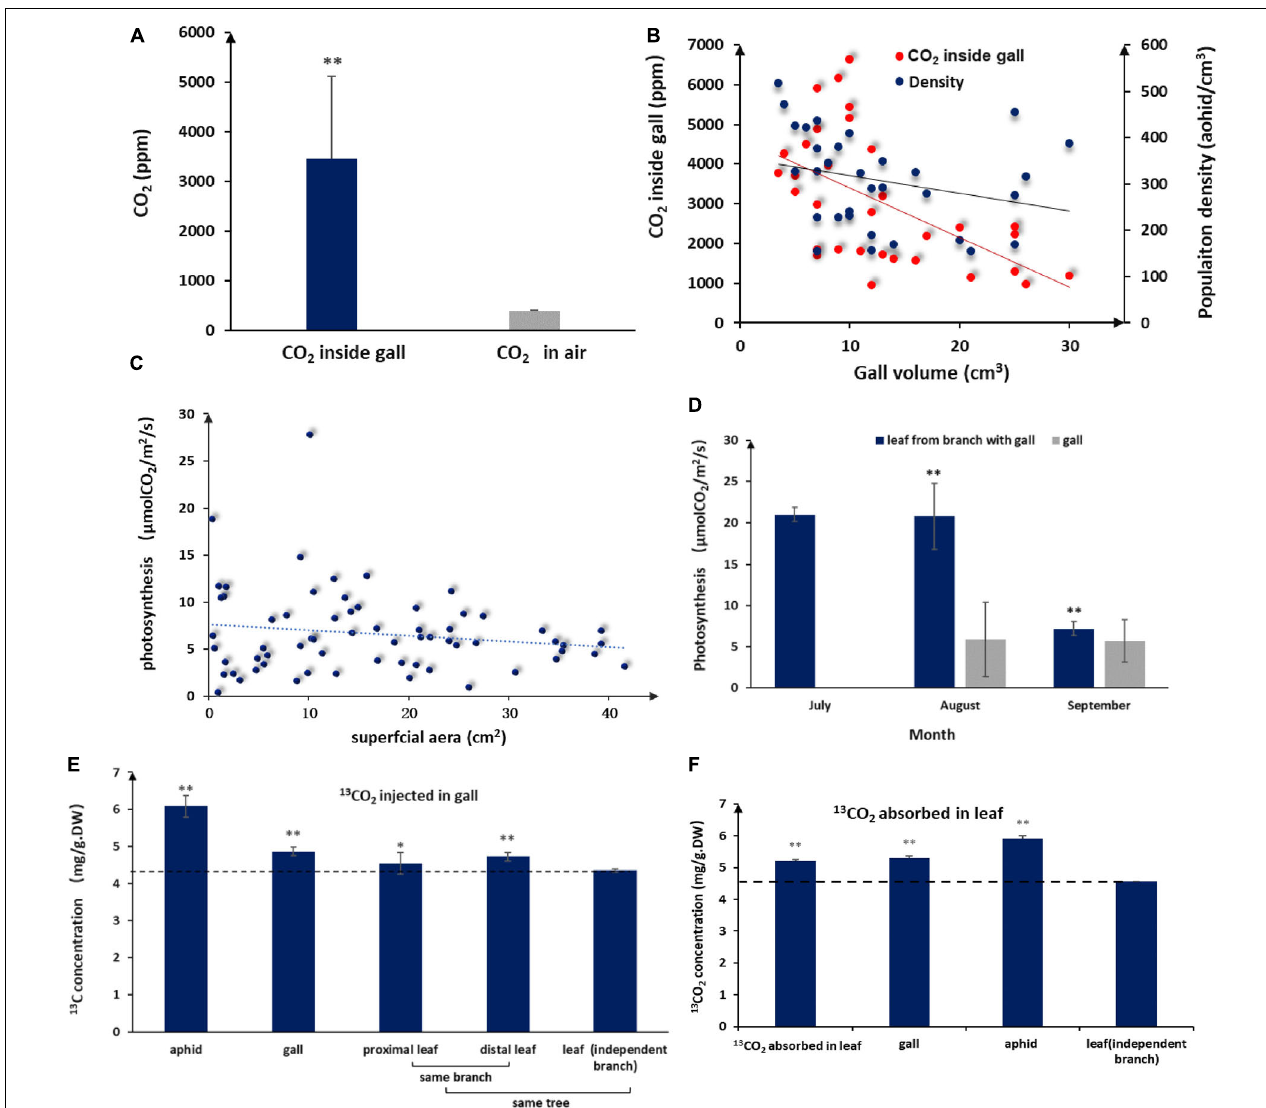
FIGURE 2 | Elevated CO 2 and photosynthesis levels in galls and leaves. (A) Average interior and exterior CO 2 concentrations ( n = 32, error bars denote SD). (B) Population density of aphid and CO 2 in the volume of different galls. (C) Photosynthesis rates of gall tissues in different sizes ( n = 66). (D) Photosynthesis rates in galls and leaves during gall development (no photosynthesis data available for July because galls are too small). (E) 13 C distribution in aphids and different plant tissues after 5 days of consecutive 13 CO 2 injections into the gall (DW = dry weight, LSD-test). (F) 13 C distribution in aphids and different plant tissues after 5 days of consecutive absorption of 13 CO 2 in a leaf close to a gall (LSD test). ** represent P < 0.01, * represent P < 0.02.